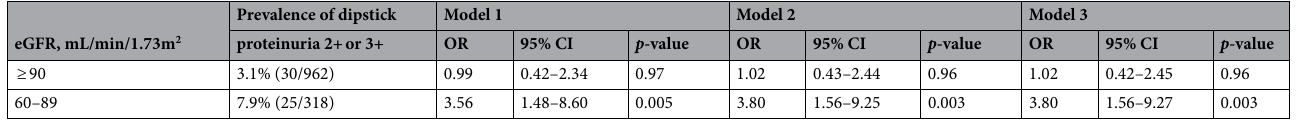
Table 3. Multivariable logistic regression analysis for the association of localized periodontitis with proteinuria in young adults with and without early chronic kidney disease. Data are presented as odds ratios (OR) and 95% confidence intervals (CI) using multiple logistic regression analysis models. Model 1: age, sex, alcohol intake, smoking and education level adjustments. Model 2: age, sex, alcohol intake, smoking, education level, BMI, mean blood pressure, fasting glucose, total cholesterol and serum triglycerides. Model 3: age, sex, alcohol intake, smoking, education level, BMI, mean blood pressure, fasting glucose, total cholesterol and serum triglycerides and remaining teeth. eGFR estimated glomerular filtration